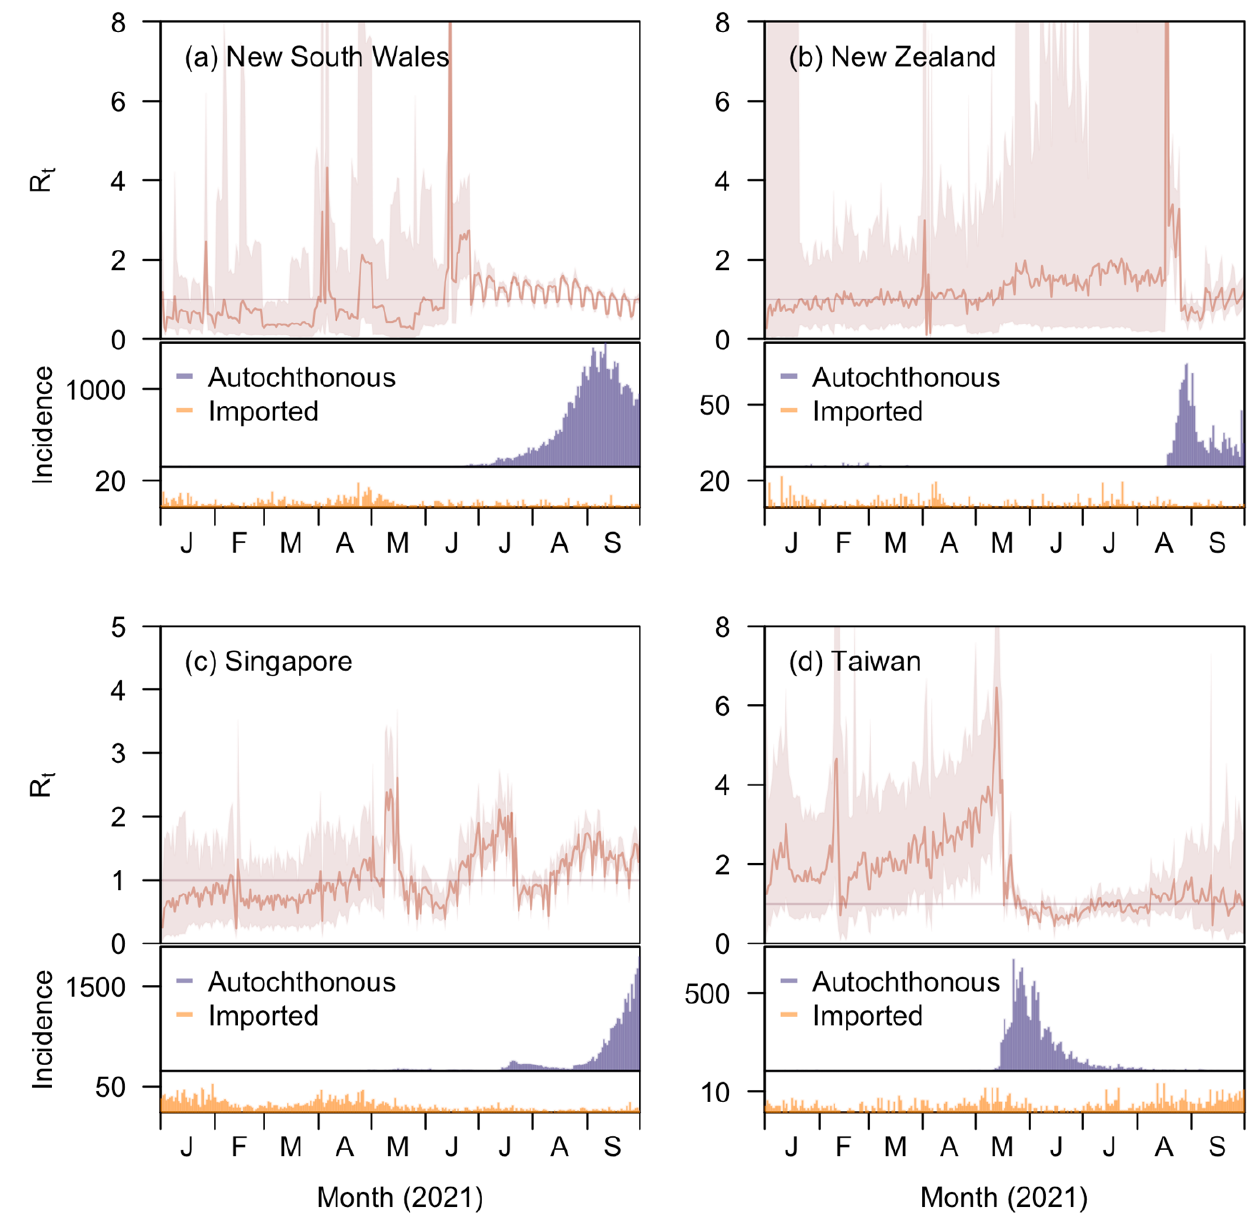
Figure 1. Estimates of time-varying effective reproduction number, R t , across time (red), together with reported numbers of autochthonous (blue) and imported (orange) new cases, in ( a ) New South Wales; ( b ) New Zealand; ( c ) Singapore; ( d ) Taiwan by EpiRegress using all the covariates available (i.e., the full model). Reported cases residing in foreign worker dormitories were excluded for both local and imported cases in Singapore.